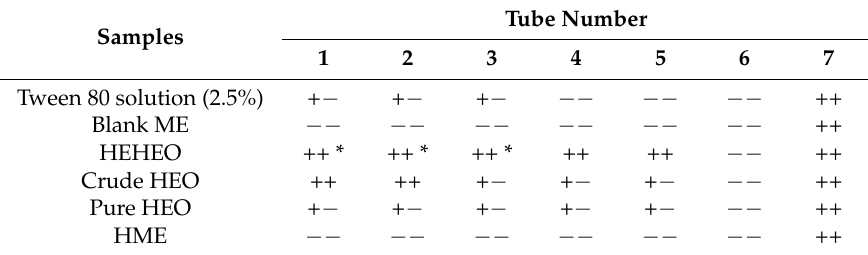
Table 4. In vitro hemolysis test results of HEHEO, crude HEO, pure HEO, and HME.